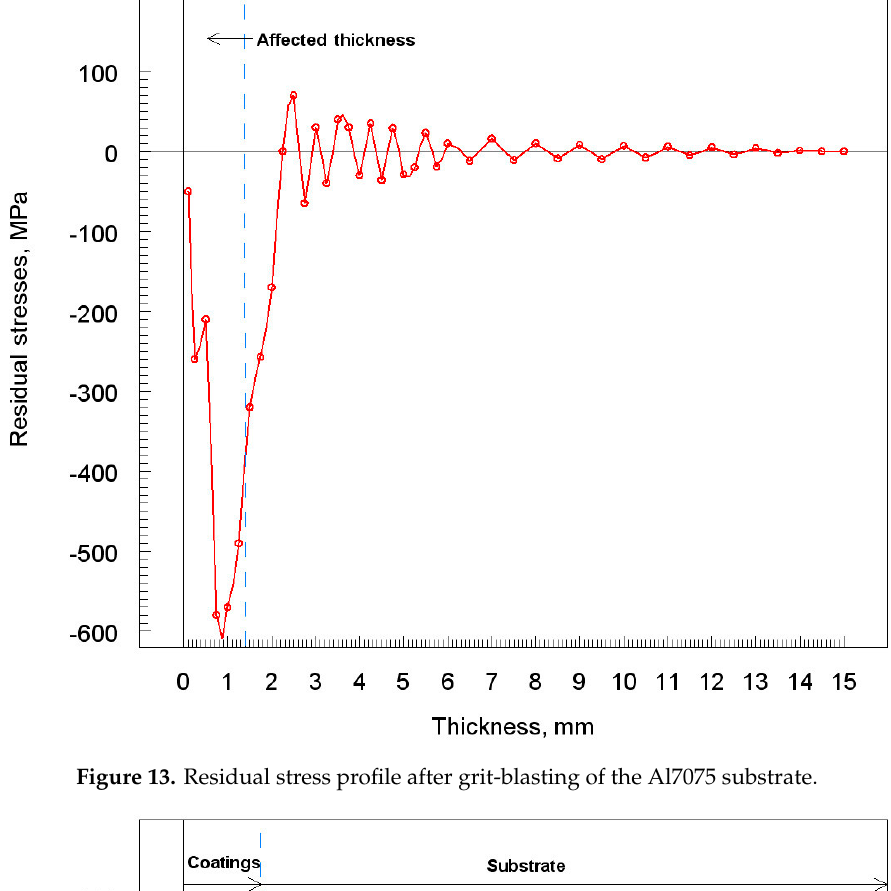
Figure 13. Residual stress profile after grit ‐ blasting of the Al7075 substrate.